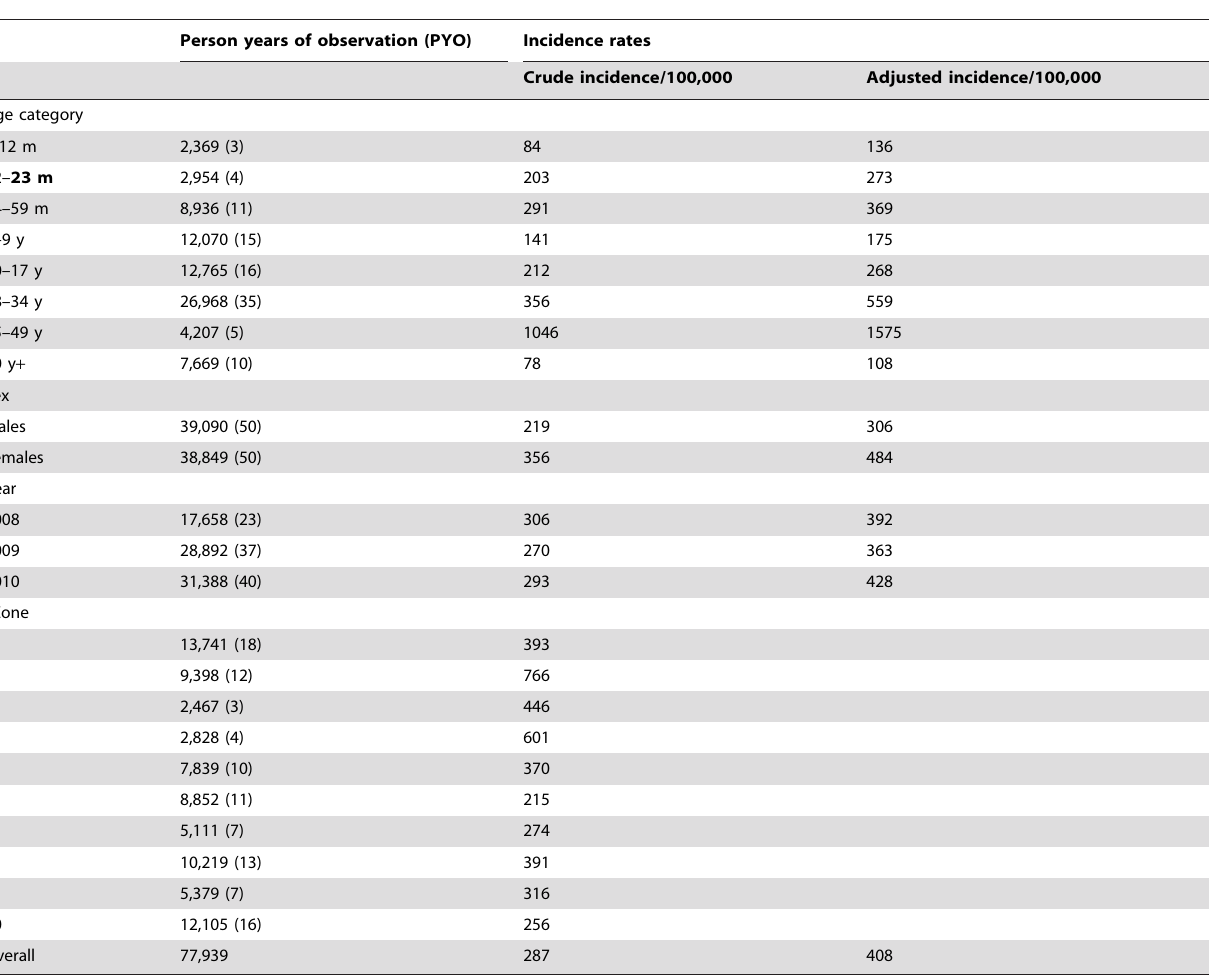
Table 1. Person years of observation, crude and adjusted incidence of Shigella by age category, sex, zone and year, 1 May 2008 to 31 Dec 2010, Kibera,